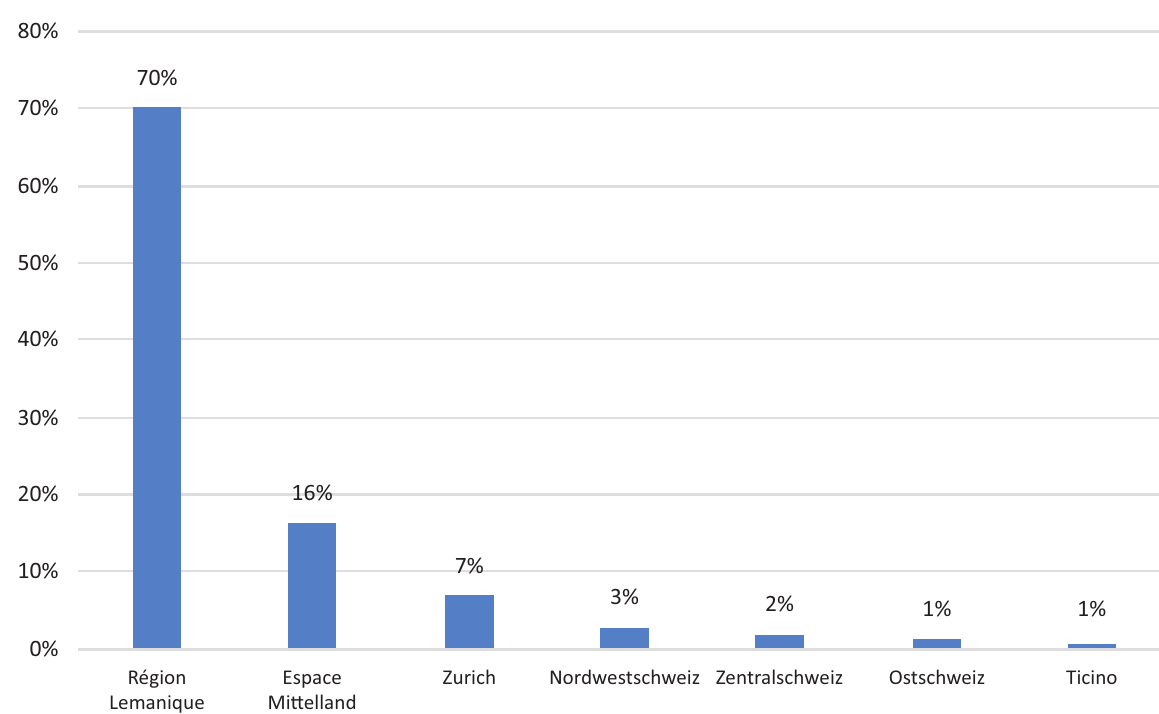
Figure 4. Distribution of participants according to the region of origin. Source: Montreux Jazz Festival